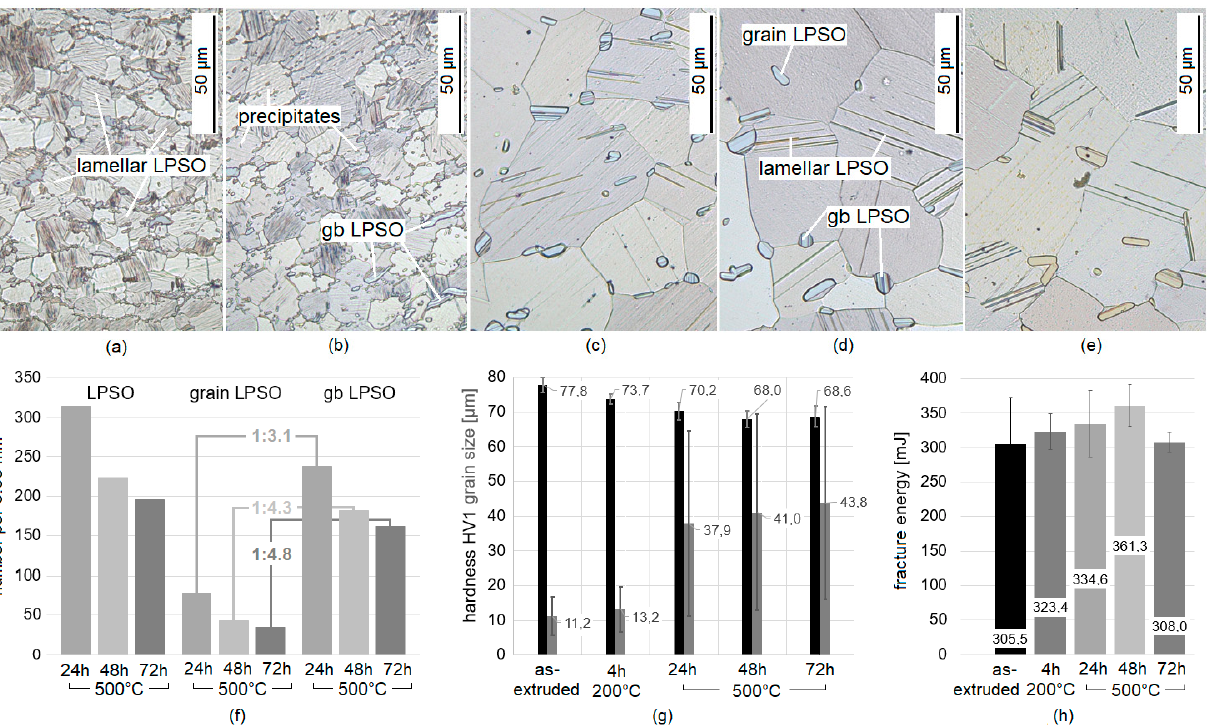
Figure 1. Microstructure of Mg ‐ Dy ‐ Nd ‐ Zn ‐ Zr alloy in as ‐ extruded and after 200 °C for 4 h ( a , b ), showing LPSO lamellae within the grains, precipitates and grain boundary (gb) long ‐ period stacking ‐ ordered (LPSO), and after 500 °C for 24 h, 48 h, and 72 h ( c – e ), showing LPSO lamellae within Mg ‐ matrix and blocky LPSO within the grain and at the grain boundaries, their amount within a certain area ( f ), its grain size and hardness HV1 ( g ) and its fracture toughness, based on [26] ( h ).